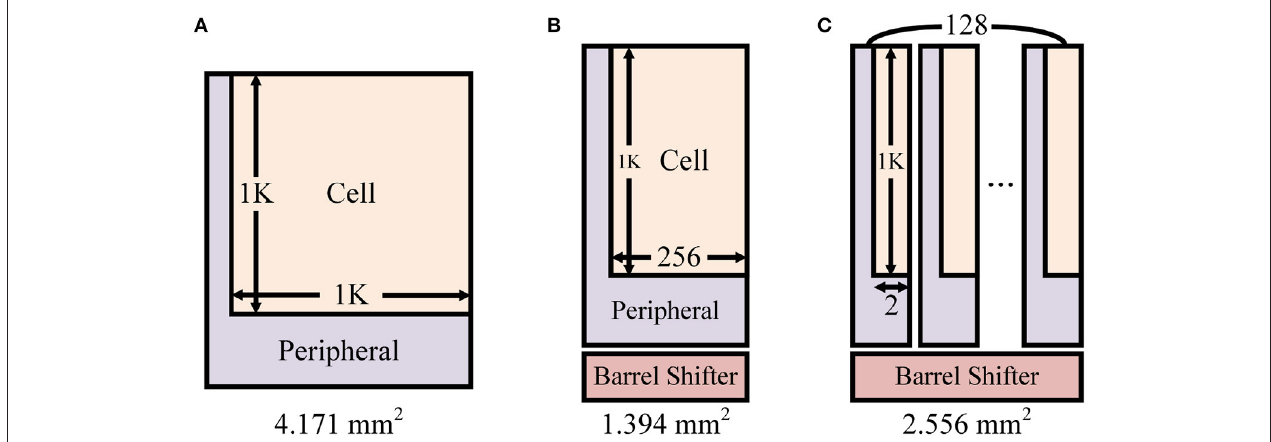
FIGURE 15 | Different SRAM crossbar synapse memory design scenarios for 1K axons/neurons: (A) 1K × 1K crossbar, (B) 1K × 256 crossbar with a barrel shifter for the axonal offset concept, and (C) Split memory blocks (128 blocks) of 1K × 256 crossbar for the transposable addressing scheme.